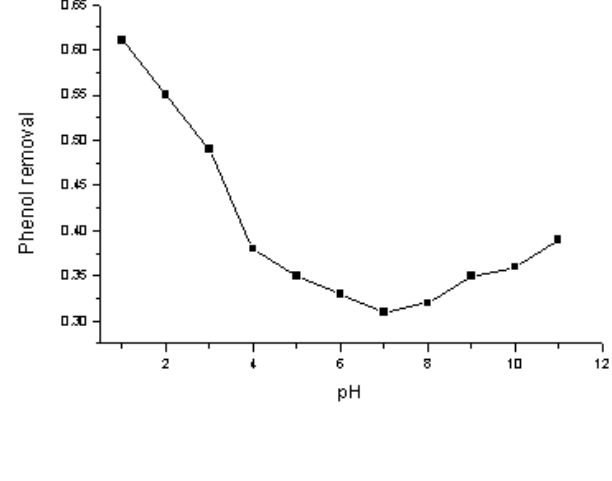
Fig. 4 The phenol removal at different